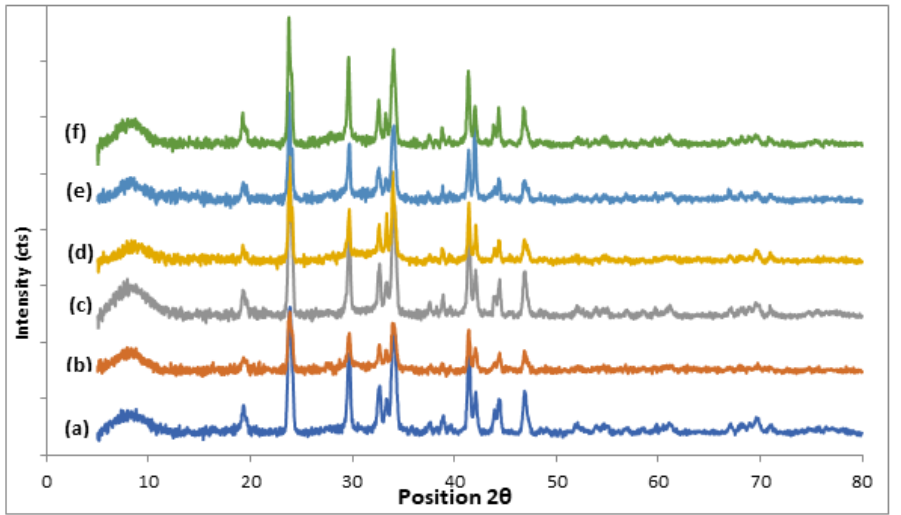
Figure 3. XRD patterns for PPVA-AlPO 4 nanocomposite samples at different pH values ( a ) pH 7; ( b ) pH 8; ( c ) pH 9; ( d ) pH 10; ( e ) pH 11; ( f ) pH 12. ( b ) pH 8; ( c ) pH 9; ( d ) pH 10; ( e ) pH 11; ( f ) pH